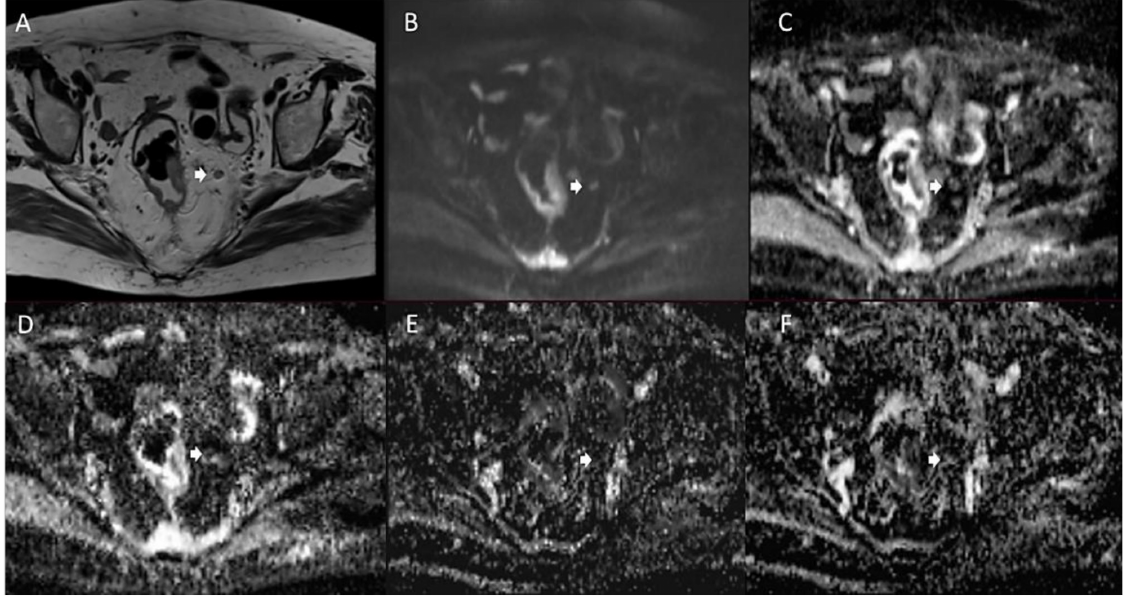
Figure 3. Man 72 y.o. with rectal cancer. Nodal assessment (arrow) in T2W sequence ( A ), in b 800 s/mm 2 ( B ), in ADC map ( C ), in Dt map ( D ), in Dp map ( E ) and Fp map ( F